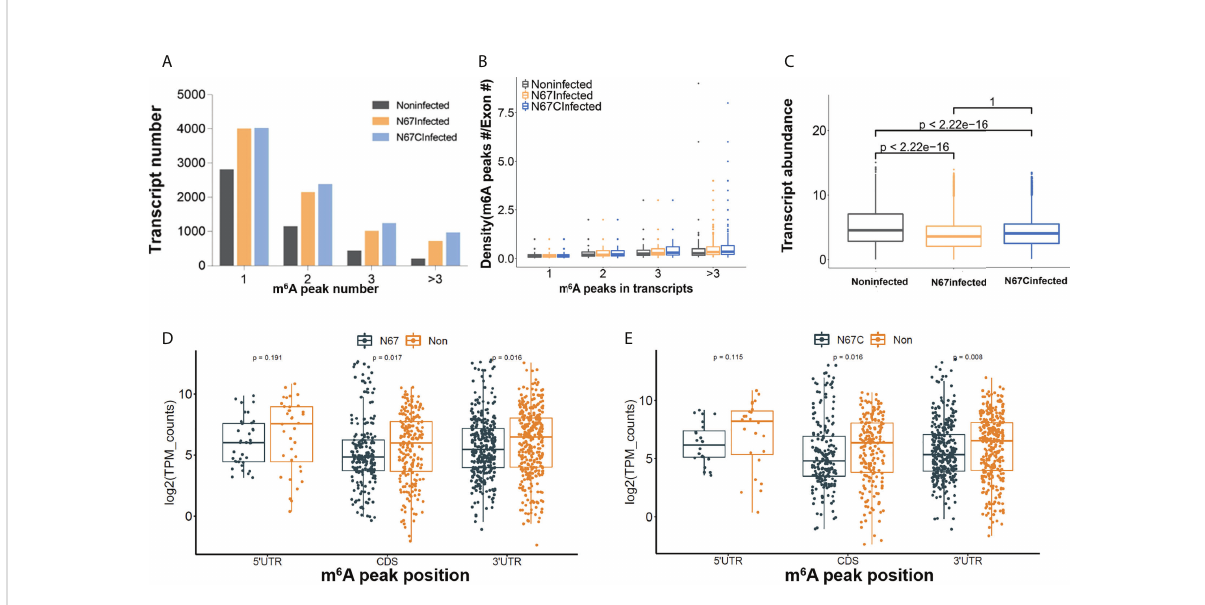
FIGURE 3 Malaria parasite infection-induced m 6 A modi fi cations impact host gene expression patterns. (A) Total number of transcripts containing different m 6 A sites in N67- or N67C-infected or noninfected spleens, respectively. (B) Plots of m 6 A peaks within exons in N67- or N67C-infected or noninfected spleens, respectively. (C) Box plots showing the abundance of m 6 A-containing transcripts in N67-, N67C-infected or noninfected spleens, respectively. Transcript abundance was shown in log2 transform. (D) Boxplot showing expression level of genes with peaks enriched in 5 ’ UTR, CDS and 3 ’ UTR in N67Infected and noninfected samples. (E) Boxplots showing expression level of genes with peaks enriched in 5 ’ UTR, CDS and 3 ’ UTR in N67CInfected and noninfected samples. R package ggboxplot was used for plots and Kruskal-Wallis test was used to show the signi fi cance between groups.